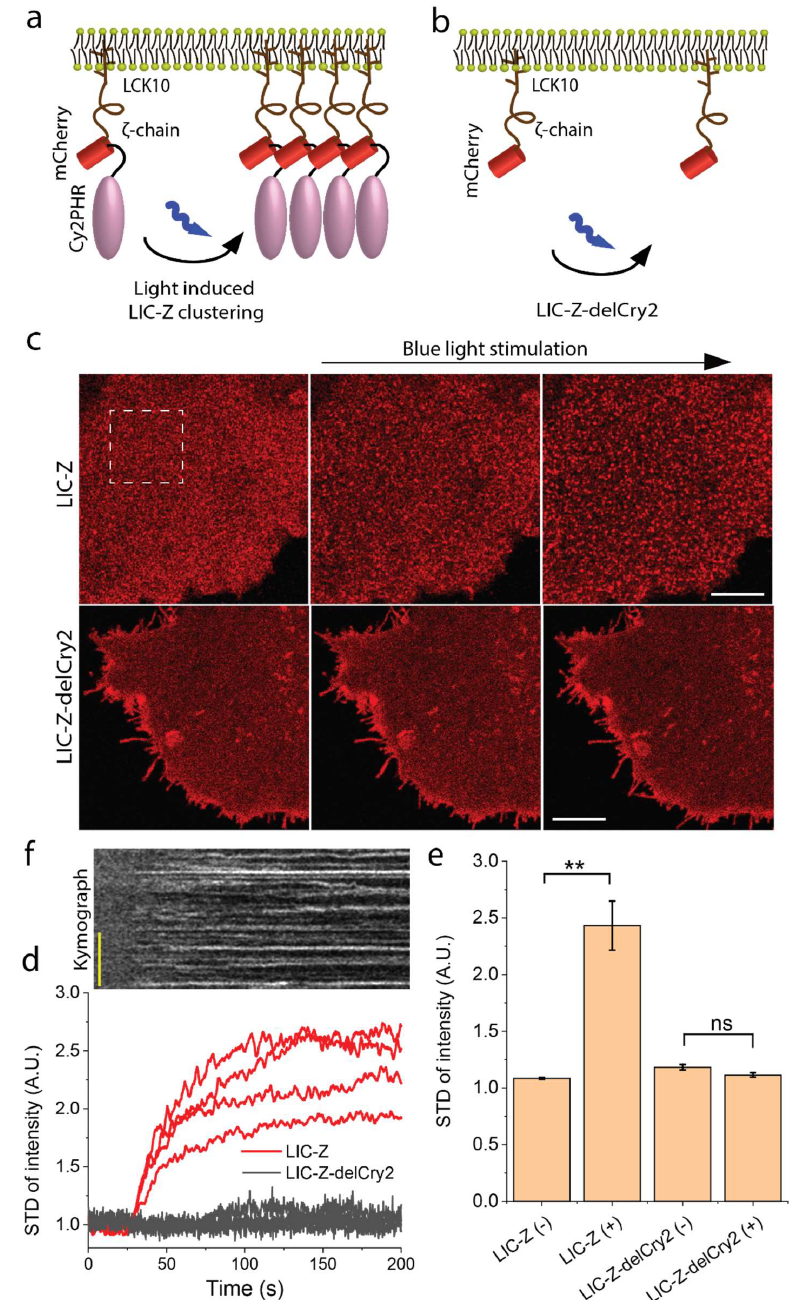
Figure 1. Light-induced clustering of ζ-chain. ( a ) Schematic of the light-induced construct, termed LIC-Z, consisting of a membrane anchor (first 10 amino acids of Lck), the cytosolic tail of ζ-chain,